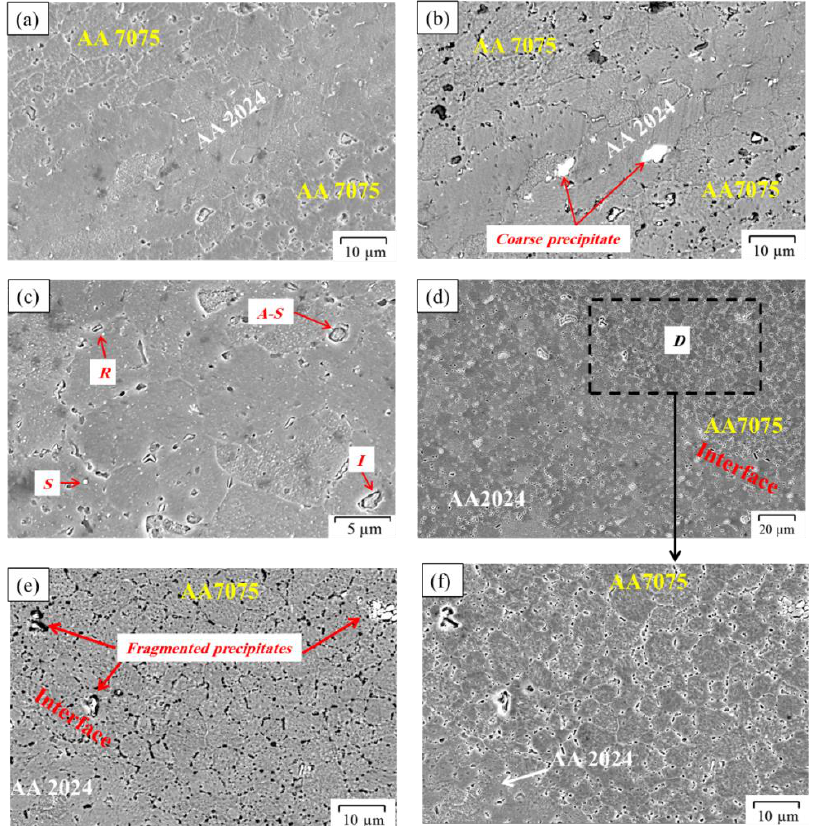
Figure 8. SEM microstructure of Friction stir welded T-joints at different rotational speeds: ( a ) ETD mode at 400 rpm, ( b ) in VCD mode, ( c ) ETD at 600 rpm, ( d ) low magnification in ETD at 800 rpm, ( e ) in VCD and ( f ) high magnification of the selected area (D) in ( d ). The FSW and FSP lead to significant change in size and morphology of the